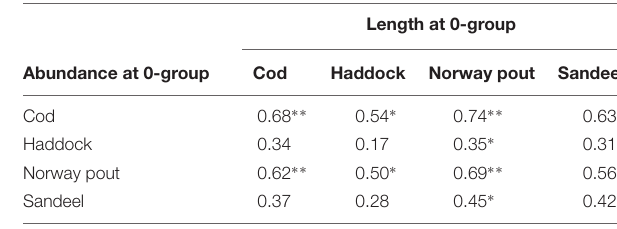
TABLE 2 | Correlations ( r ) between log-transformed abundance and mean length at the pelagic 0-group stage of cod, haddock, Norway pout, and sandeel within the CS